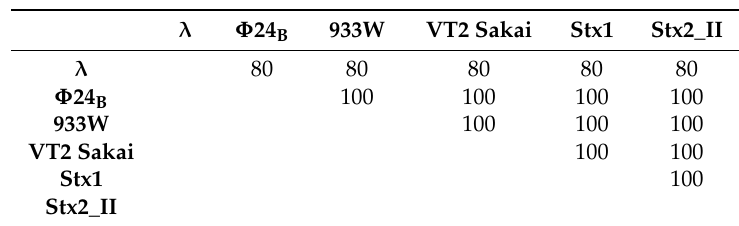
Table 4. Scores of pairwise alignments of the nucleotide sequences of orf61 from six analyzed